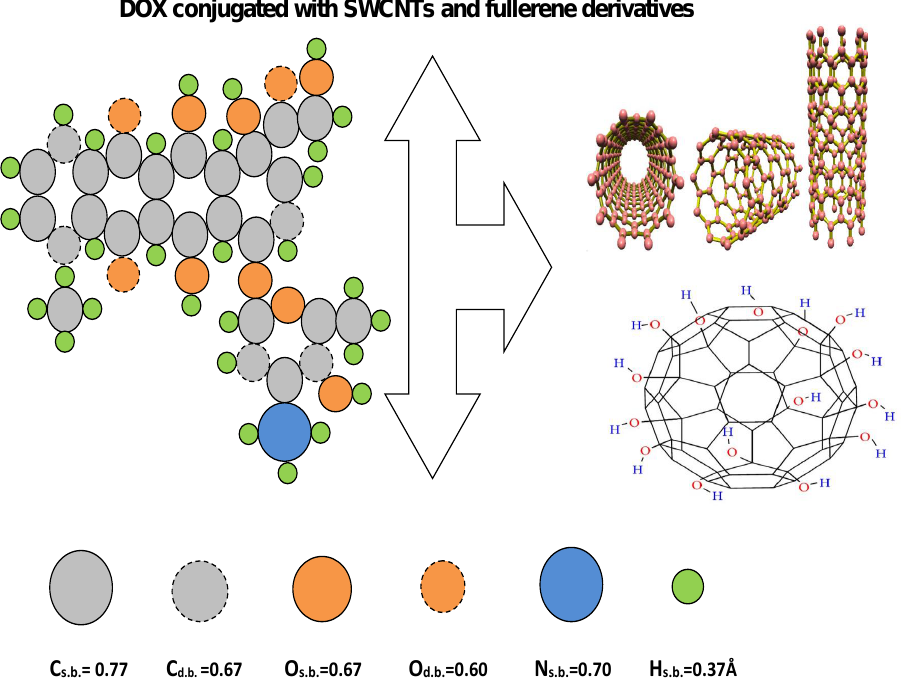
Figure 1. Geometrical structure for DOX molecule conjugated with CNPs (SWCNTs varying in radius r and fullerene derivatives (C N -[OH] β